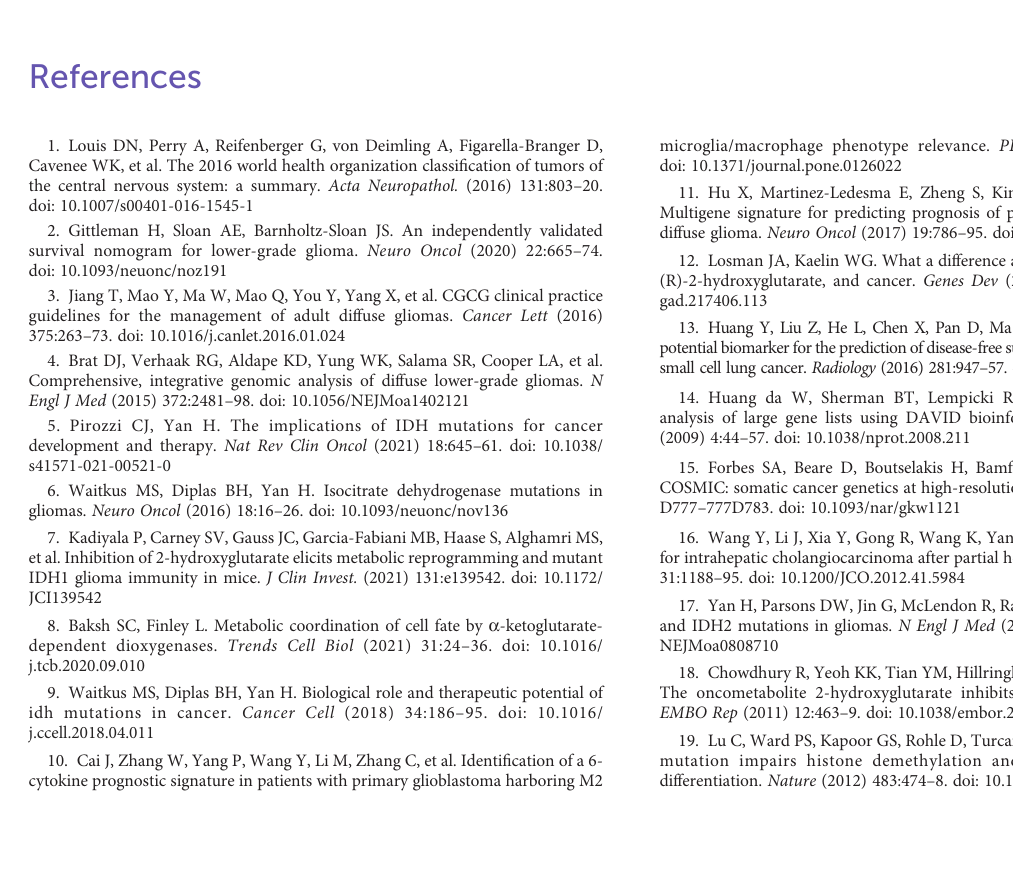
SUPPLEMENTARY FIGURE 1 The expression of candidate genes between normal and lower-grade gliomas in GTEx and TCGA. SUPPLEMENTARY FIGURE 2 Survival analyses for individual genes in CGGA cohorts. SUPPLEMENTARY FIGURE 3 Survival analyses for individual genes in TCGA cohorts. SUPPLEMENTARY FIGURE 4 Prognostic signi fi cance of the enzyme-based risk signature in TCGA and Rembrandt datasets. SUPPLEMENTARY FIGURE 5 Prognostic signi fi cance of the enzyme-based risk signature in GSE16011 dataset. SUPPLEMENTARY FIGURE 6 Biological Processes and cellular components analyse of risk-score positively associated genes in TCGA, GSE16011 and Rembrandt datasets. SUPPLEMENTARY FIGURE 7 Associations between the risk value and the clinicopathologic features in GSE16011 and Rembrandt cohorts. SUPPLEMENTARY FIGURE 8 Pharmacogenomic interaction analysis. (A) Heatmap of targeted drugs with R>0.35 or R<-0.35. (B-G) Pearson correlation analyses of candidate